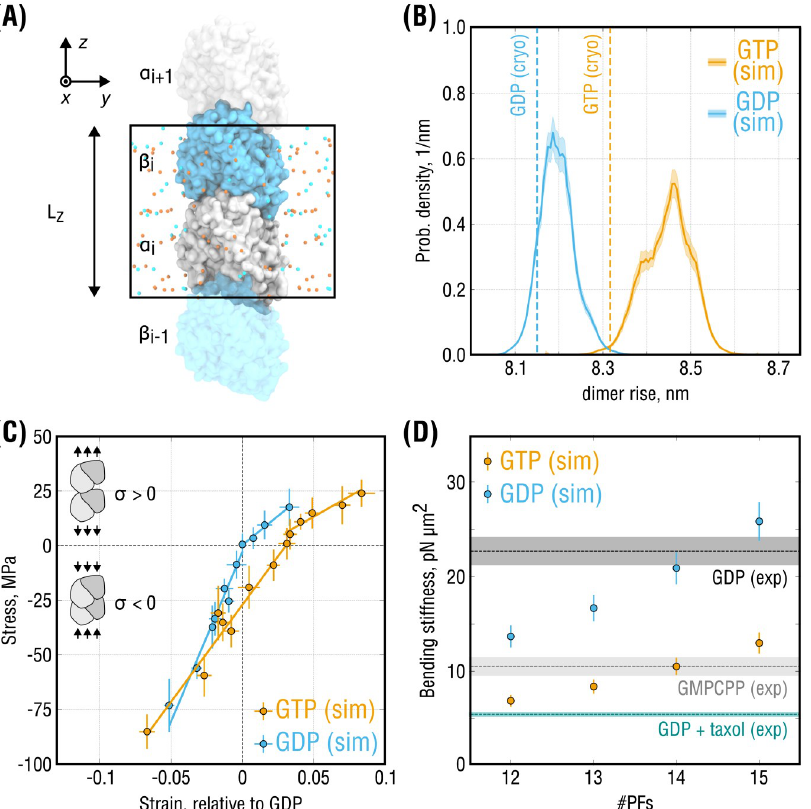
Fig 2. Elastic properties of isolated ‘infinite’ PFs. (A) , Simulation setup for the single-PF system. α -tubulin (gray) and β -tubulin (cyan) are shown in surface representation. Potassium and chloride ions are shown as orange and cyan spheres, respectively. Water molecules are hidden for clarity. Periodic box with the axial dimension L black rectangle. (B) , Equilibrium probability distributions of the dimer rise in the PFs obtained from stress-free simulations of the system in (A) . Shaded areas show statistical uncertanties of the distributions estimated with umbrella sampling. Dashed lines indicate the dimer rise values observed in the cryo-EM densities of GMPCPP- and GDP-MTs. (C) , Stress-strain curves calculated for the system in (A) in both GTP- (orange) and GDP-state (cyan). Strain is computed relative to the equilibrium dimer length of GDP-PF, and negative (positive) stresses correspond to PF compression (extension). Only separate fits to the positive and negative stress ranges are shown. (D) , Bending stiffness parameters of GTP- and GDP-MTs calculated using the elastic moduli in (B) (all stress values) and for varying PF numbers (orange and cyan dots, respectively). Experimental values (dashed lines with shaded areas) represent inverse-variance weighted means and standard deviations that combine multiple independent thermal fluctuation measurements summarized in [29] and recently updated in